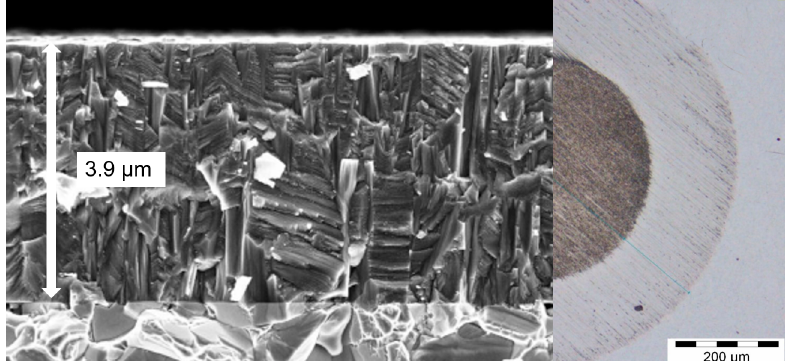
Figure 28. Cross-section and calotte of an industrially applied HiPIMS (S3p) (AlCr)N coating, BALIQ ® ALCRONOS, courtesy of Oerlikon Balzers.